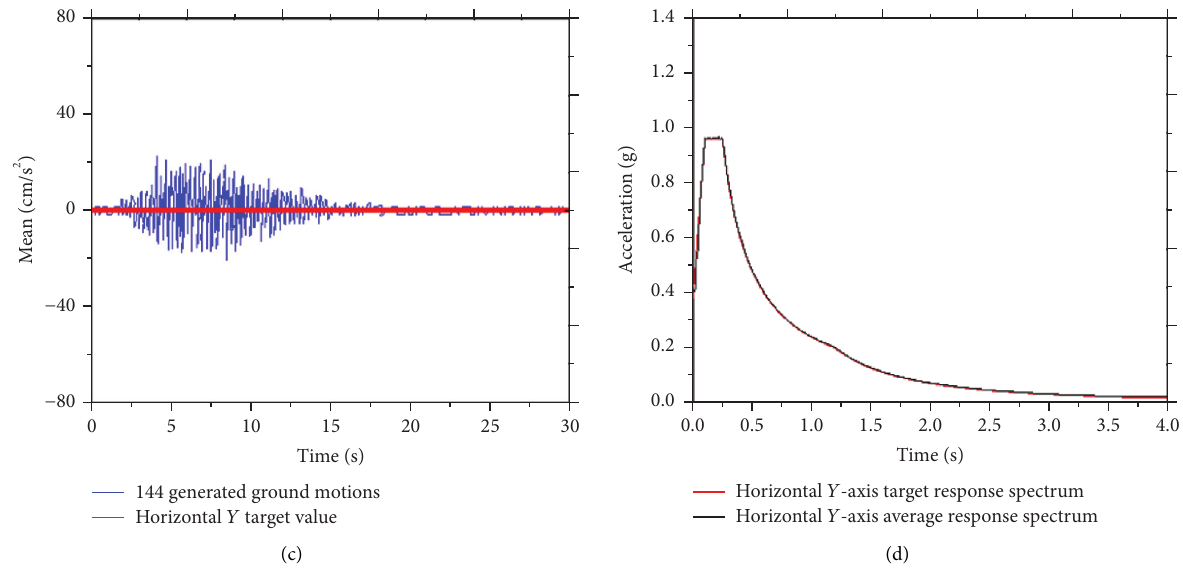
Figure 7: Comparison of the horizontal Y component of the sample with the target value. (a) Representative time history, (b) mean, (c) standard deviation, and (d) average response